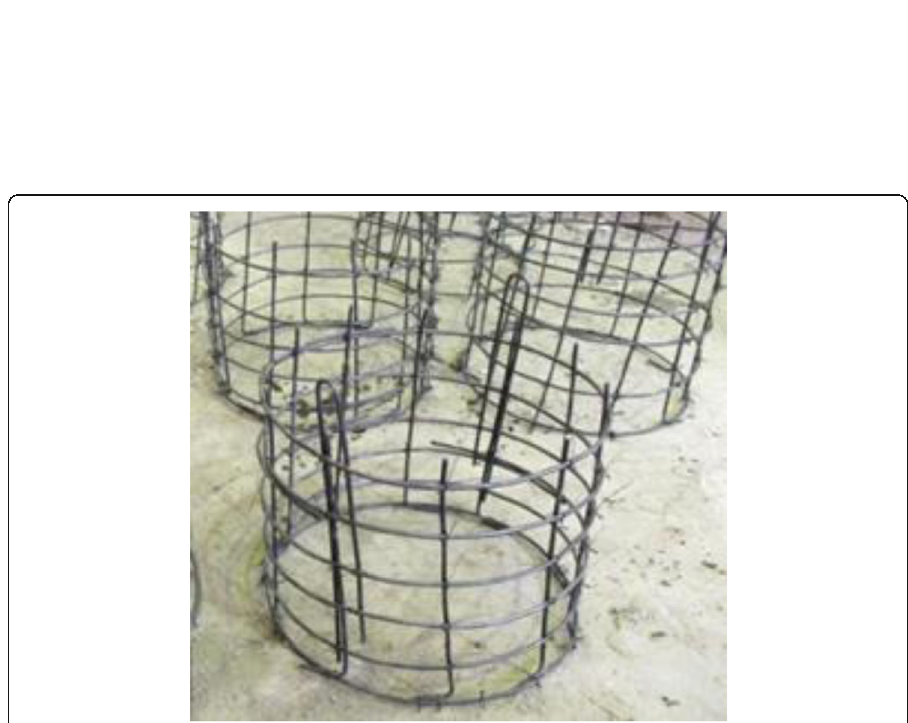
Fig. 3 The typical reinforcement of the